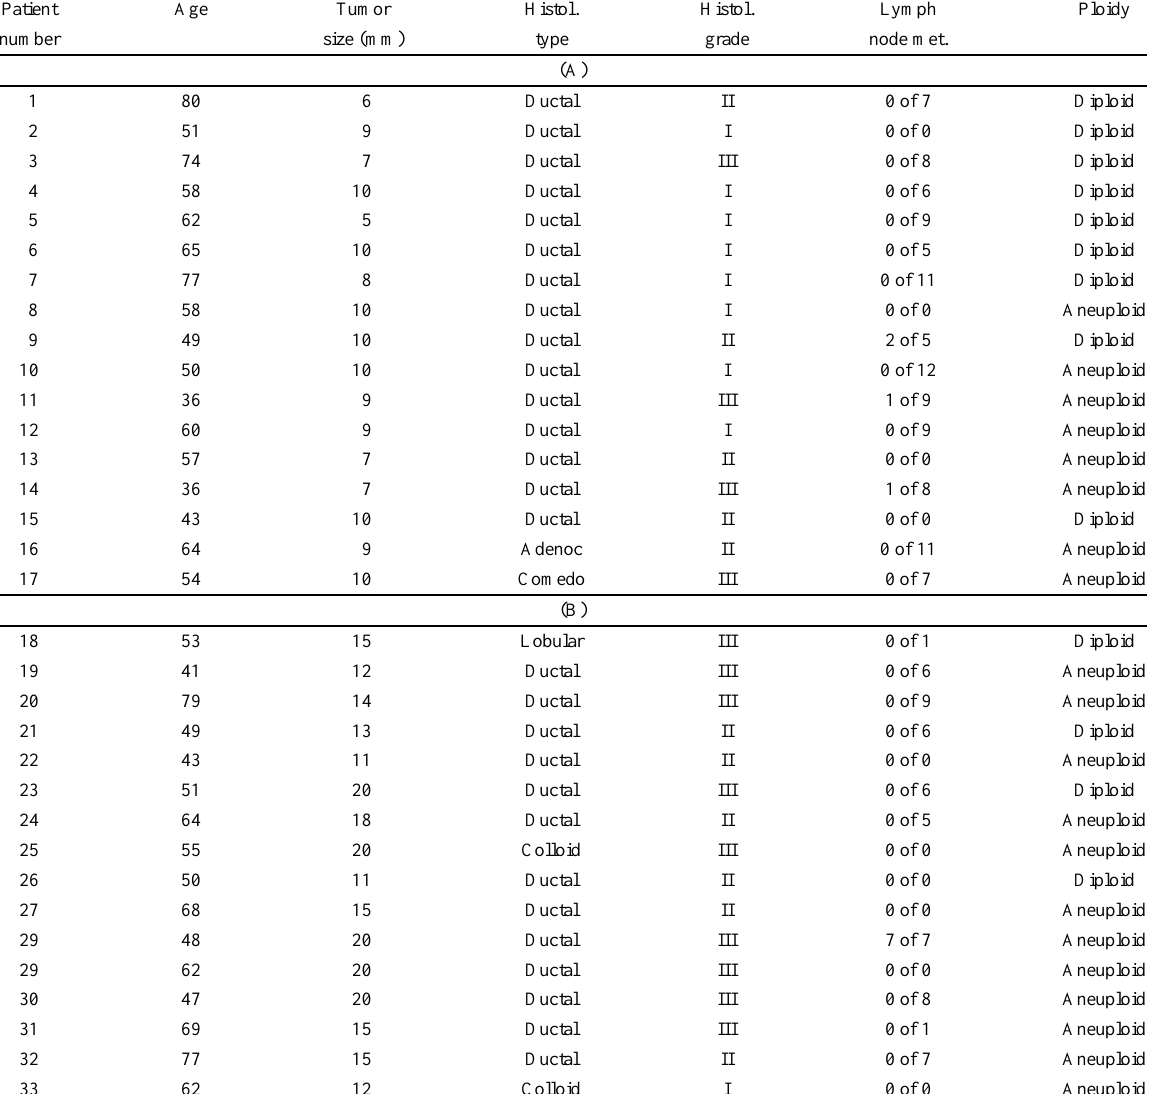
Clinicopathological characteristics of T1b (A) and of T1c (B) breast